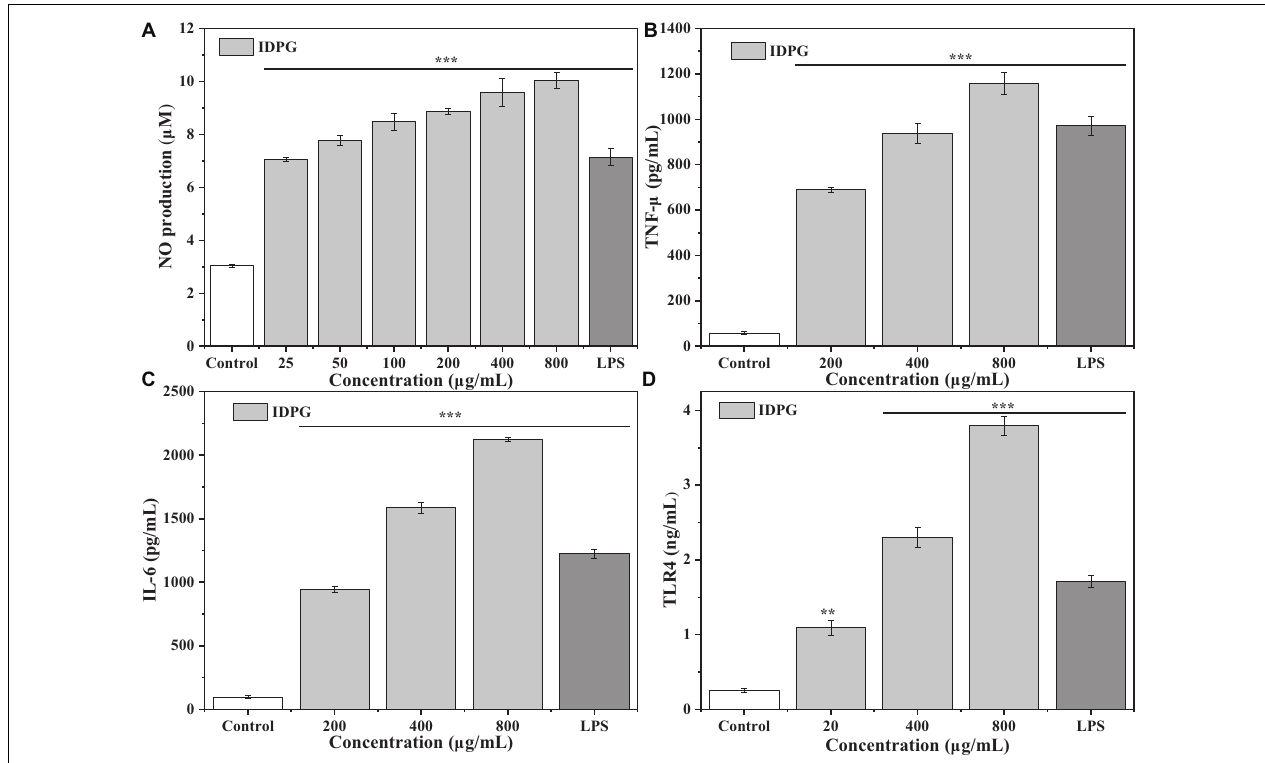
FIGURE 3 | Effect of incomplete degradation products of galactomannan (IDPG) on the NO production (A) and the secretion of tumor necrosis factor- α (TNF- α ) (B) , interleukin 6 (IL-6) (C) , and Toll-like receptor 4 (TLR4) (D) in RAW 264.7 cells. Cells were treated with IDPG for 24 h. Data were all in triplicate, and significance was determined by ANOVA; ** P < 0.01, *** P < 0.001 as compared to the control